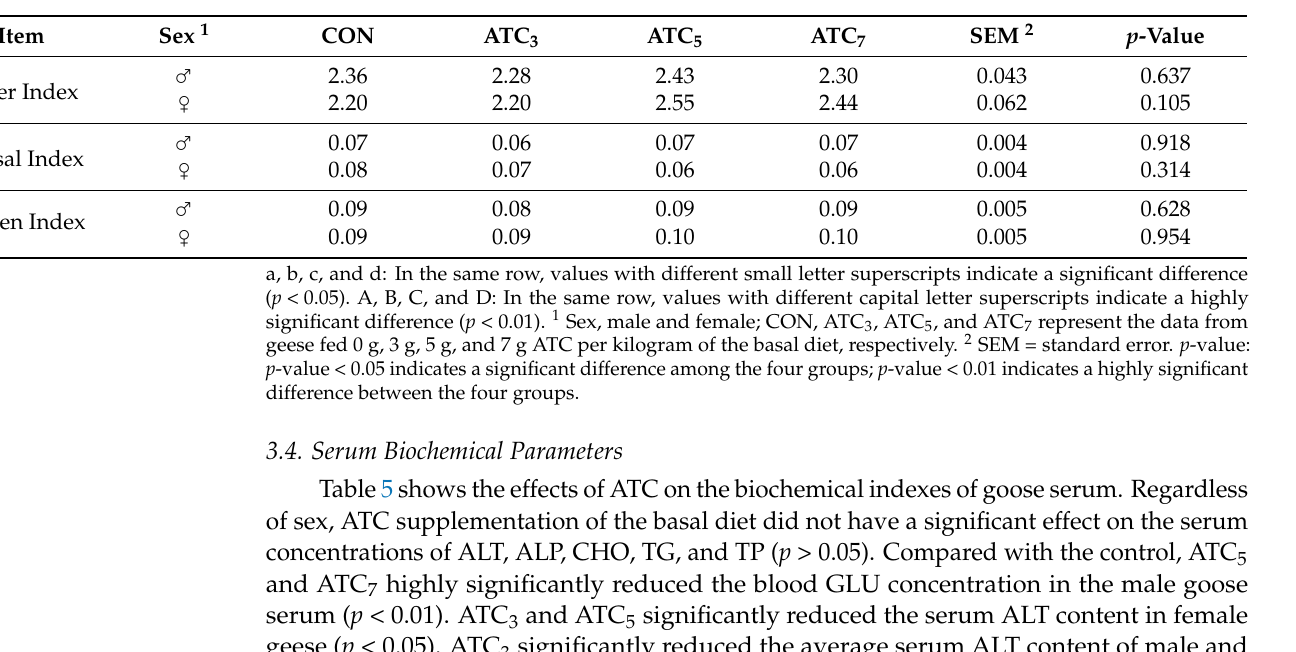
Table 4. Effects of ATC on the immune organ index (%) of geese ( n = 12).